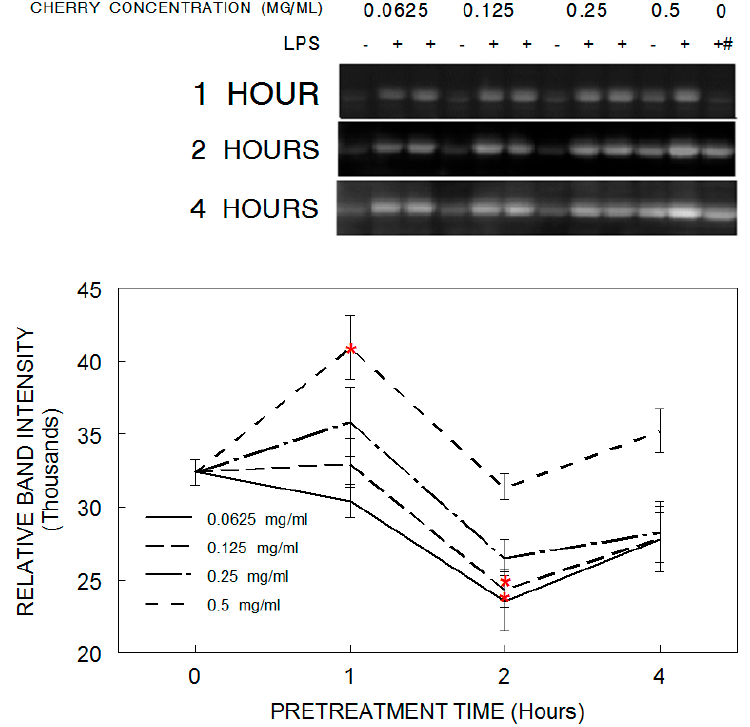
Figure 4. Reduction in cyclooxygenase-2 (COX-2) expression in HAPI microglial cells pretreated with tart cherry powder (0.062, 0.125, 0.250, or 0.500 mg/mL) for 0 (LPS only/alone control), 1, 2, or 4 h and stimulated overnight with lipopolysaccharide (LPS, 100 ng/mL). Quantitative measurements were made based on the Western blots, and are expressed as mean ± SEM for the immunoreactive band density. Each tart cherry pretreatment was compared against LPS treatment alone. Comparative post hoc analyses were made by Tukey’s HSD with significance at (*) p < 0.05 versus LPS. # column represents blots for 0 cherry with either no LPS (in the 1 h row) or LPS (in the 2 and 4 h